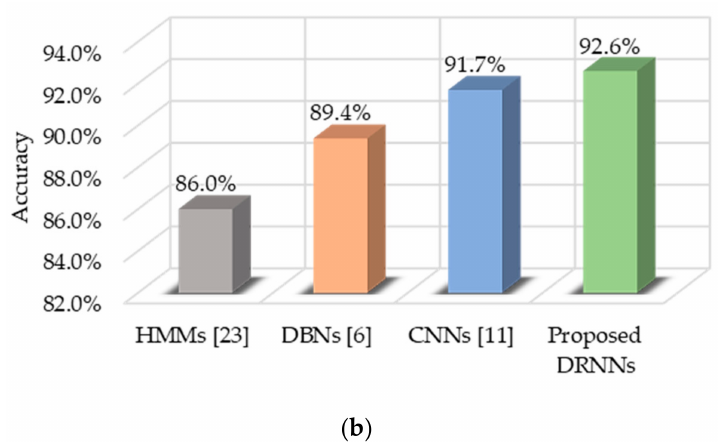
Figure 12. Performance results of the proposed cascaded DRNN model for the Skoda dataset: ( a ) Confusion matrix for the test set as well as per-class precision and recall results; ( b ) Comparative accuracy of proposed model against other methods.